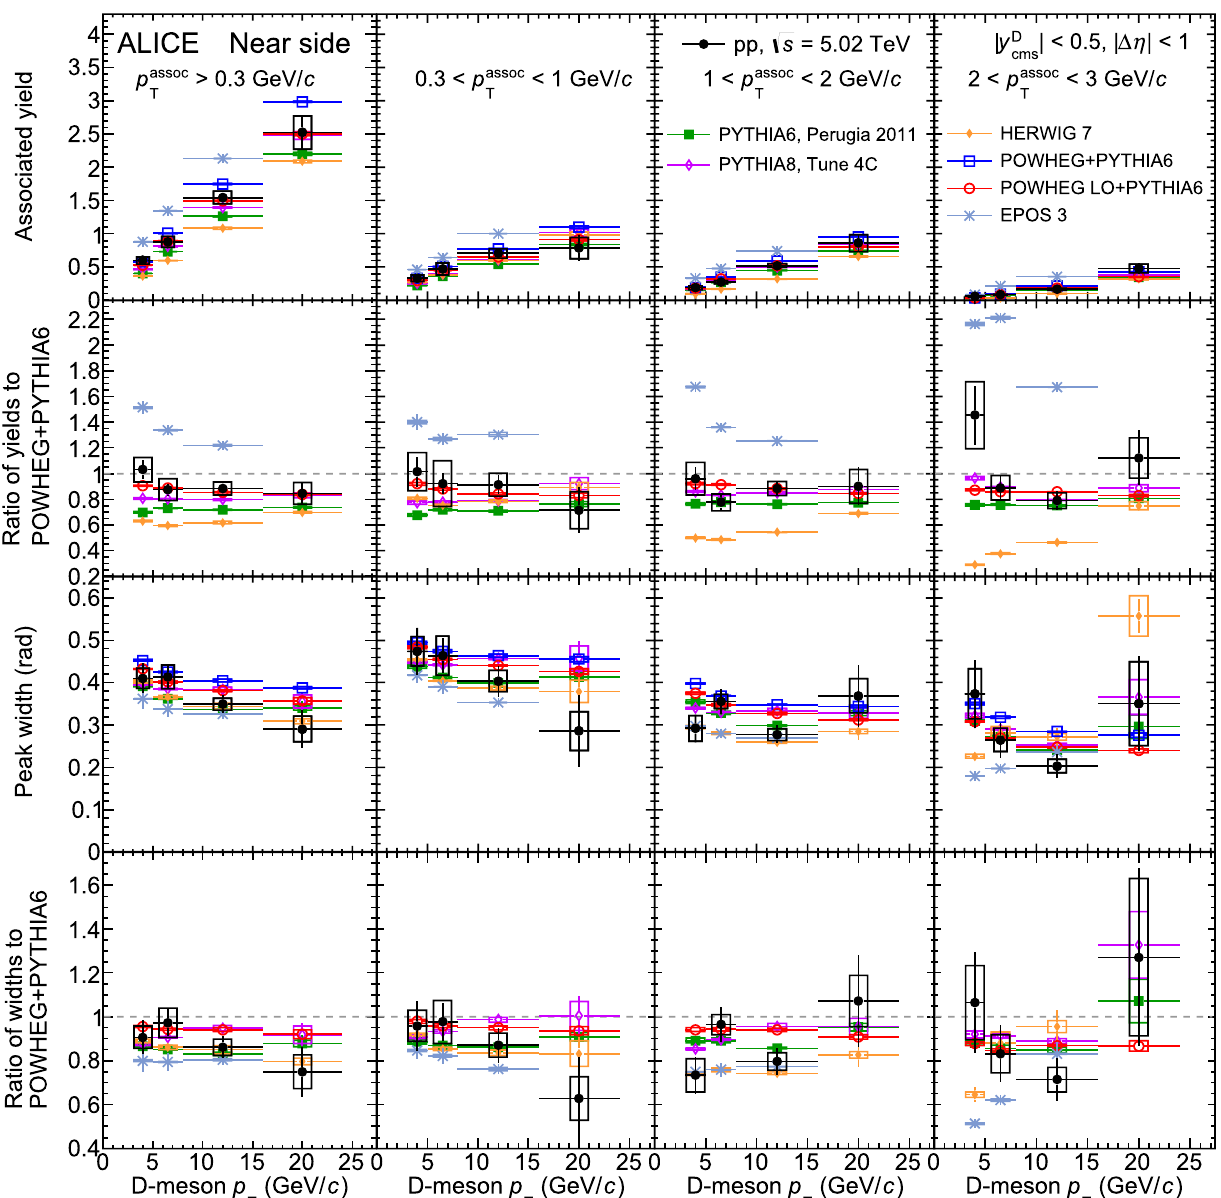
Fig. 9 Measurements of near-side associated peak yields (top row) and widths (third row down) in pp collisions at paredtopredictionsbythePYTHIA,POWHEG+PYTHIA6,POWHEG LO+PYTHIA6, HERWIG, and EPOS 3 event generators with various configurations (see text for details). The ratios of yield (width) values with respect to the predictions by POWHEG+PYTHIA6 are shown in